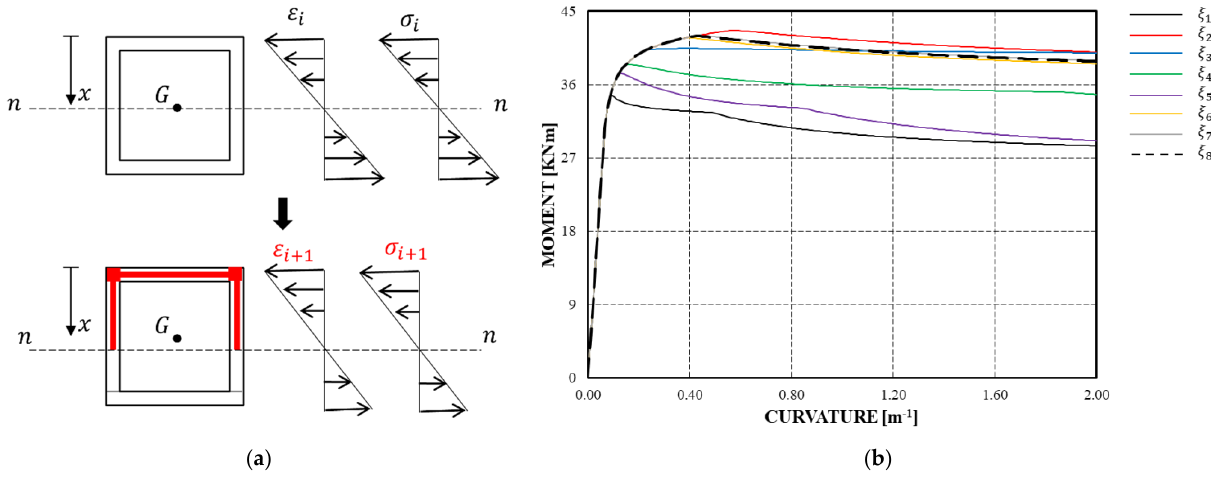
Figure 5. Scheme of a generic box section in bending ( a ). The moment-curvature curves by varying the plastic coefficient 𝜉 ( b ).